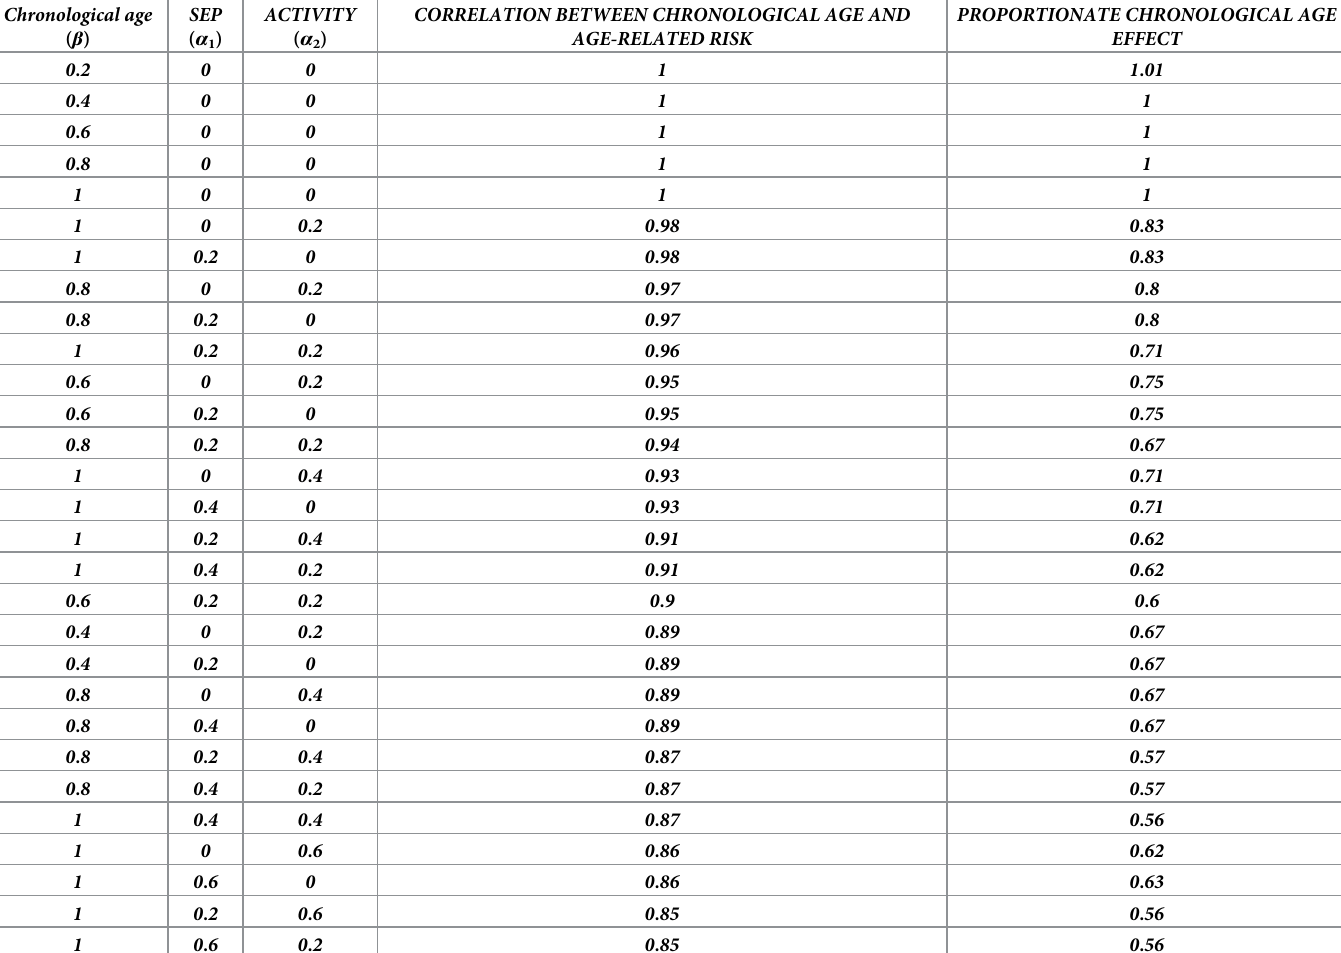
Table 2. Simulated slope parameter patterns in which the average correlation between chronological age and age-related risk was greater than or equal to 0.85. Chronological age ( β